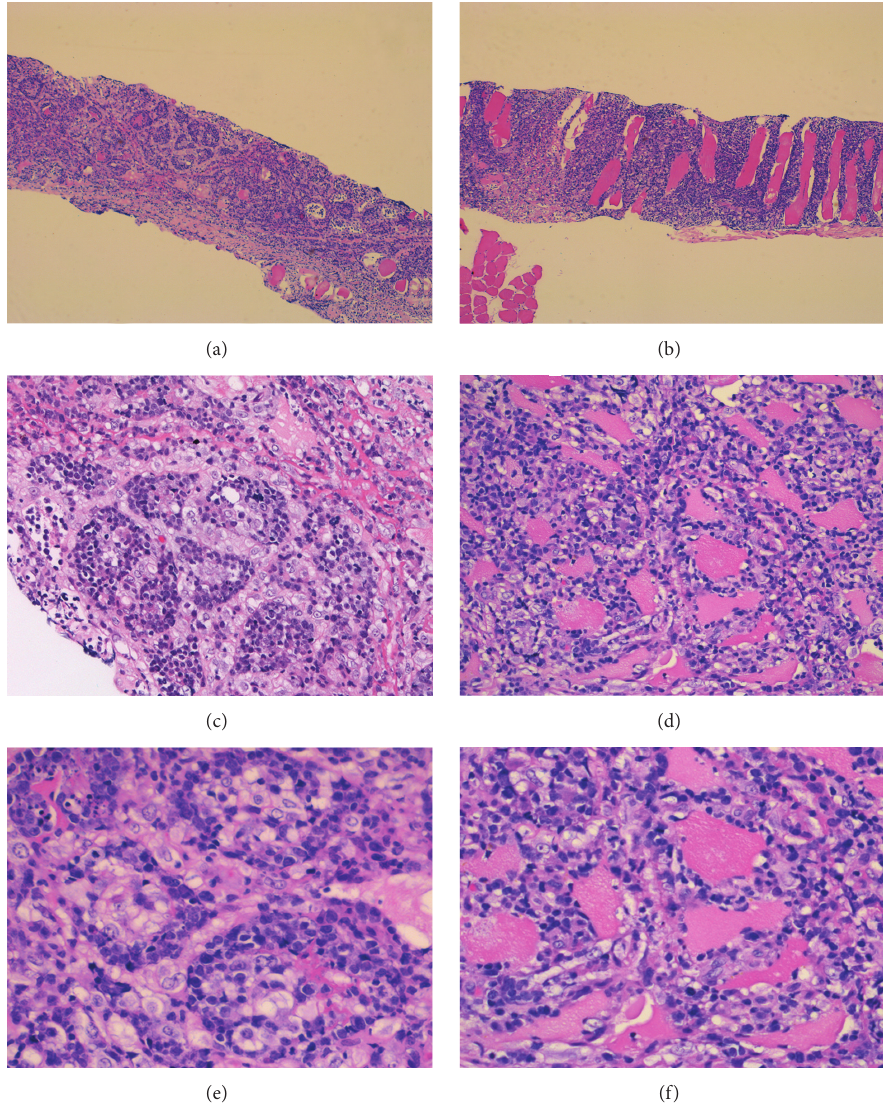
Figure 3: Histological findings of the muscle biopsy. Low power view (H&E stain, 5x) shows dense lymphoid infiltrate forming peculiar pseudoglandular structures (a) and sheets (b). Medium (H&E stain, 20x) and high power (H&E stain, 40x) stain view of the pseudoglandular structures (c and e) and areas densely infiltrating muscle tissue (d and